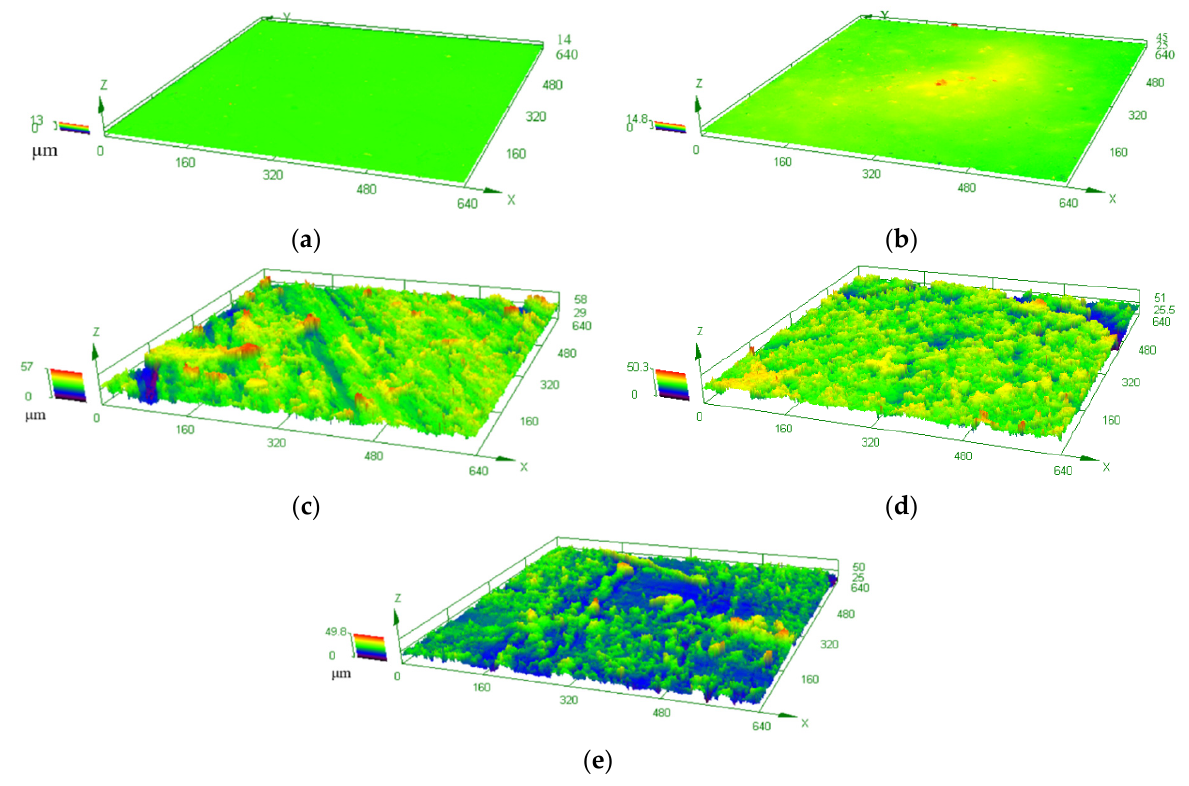
Figure 3. Surface 3D-micro morphologies of ( a ) 0#, ( b ) #1, ( c ) #2, ( d ) #3, and ( e ) #4. Table 4. Average values of surface roughness for different coatings.